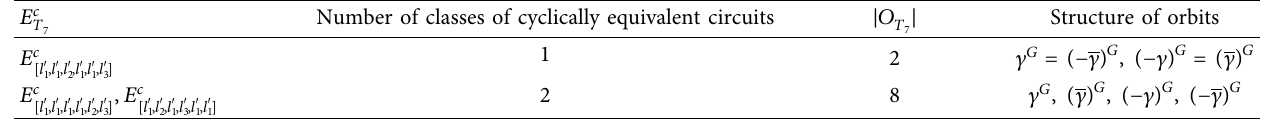
Table 5: Cyclically equivalent classes of T